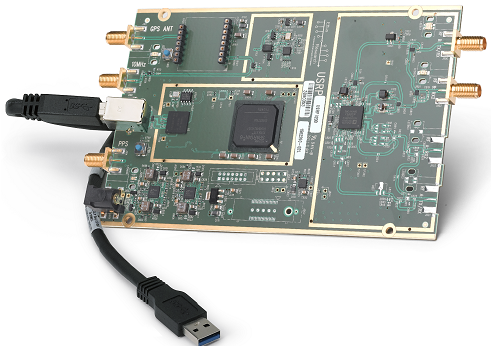
Figure 3. USRP B200 by Ettus Research. Its price is currently